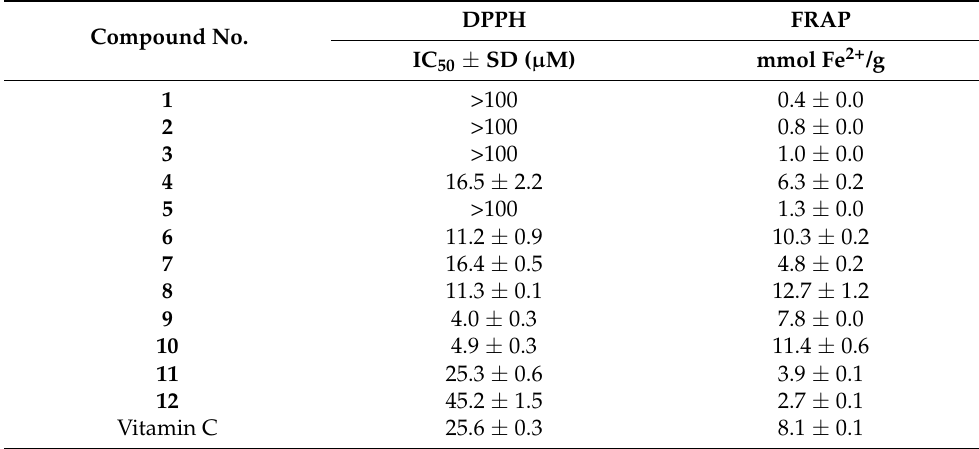
Table 3. The antioxidant activities of compounds 1 – 12 and vitamin C with the DPPH and FRAP assays. DPPH Compound No.